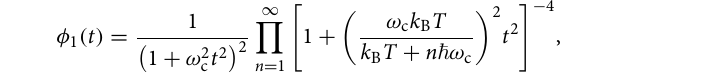
1 , k B / (cid:31) 1 , and increasing T from 0 to 5 (decreasing opacity). The left panel of Fig. 3a shows Fig. 3a with ω c = = the dynamical behaviour of φ 1 ( t ) . It exhibits a Markovian pure dephasing as φ 1 ( t ) decreases monotonically; 1 (ω) , which broadens when increasing T , reflecting stronger thermal